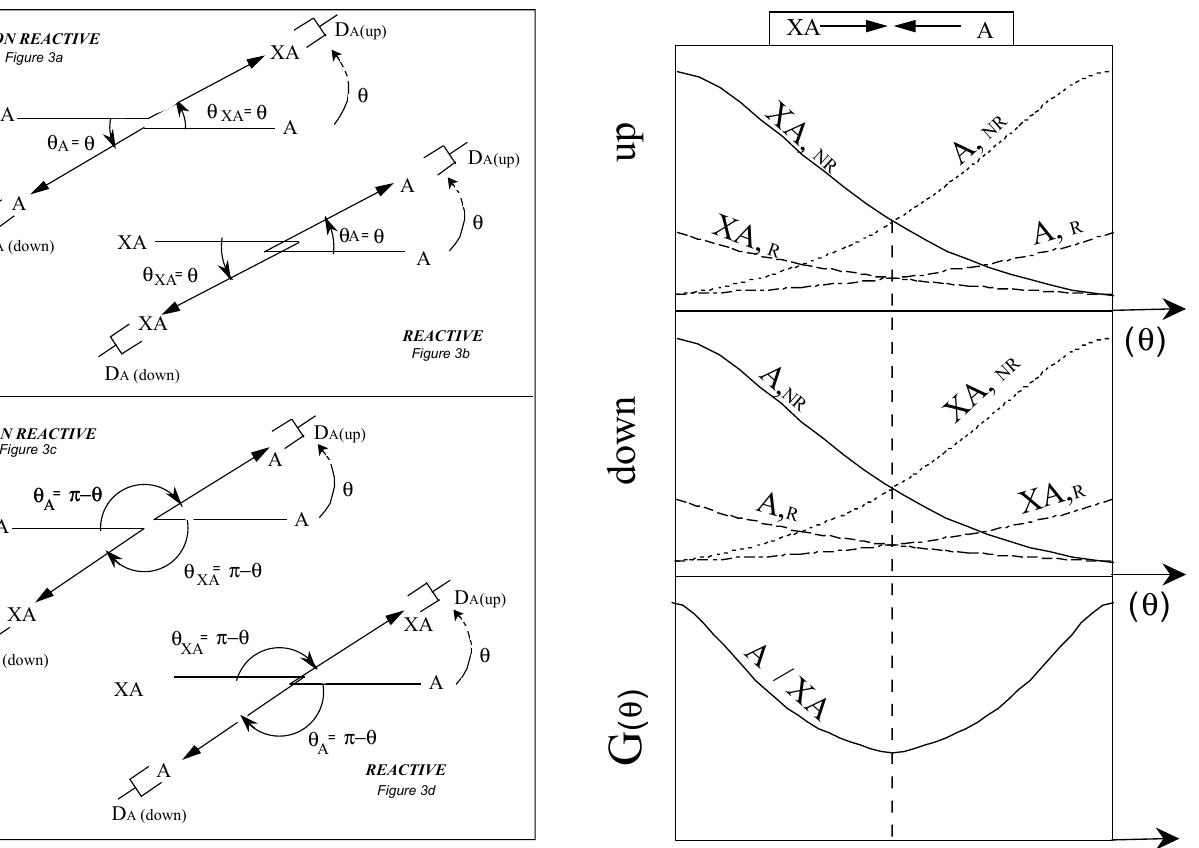
Figure 4 : F. Robert & C. Camy-Peyret in Ozone isotopic composition